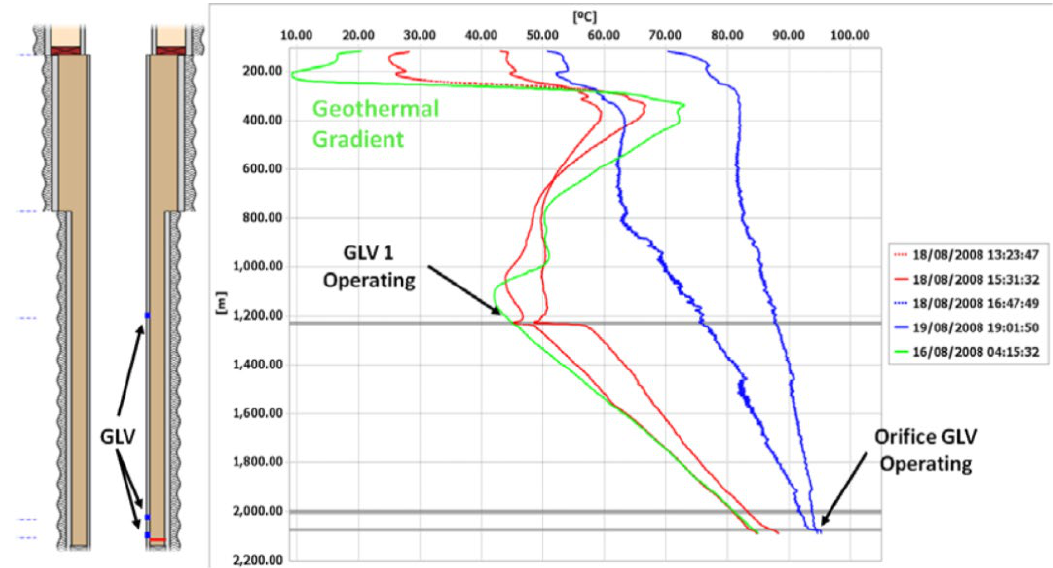
Figure 5. Monitoring of gas lift based on Joule–Thomson effect [11].